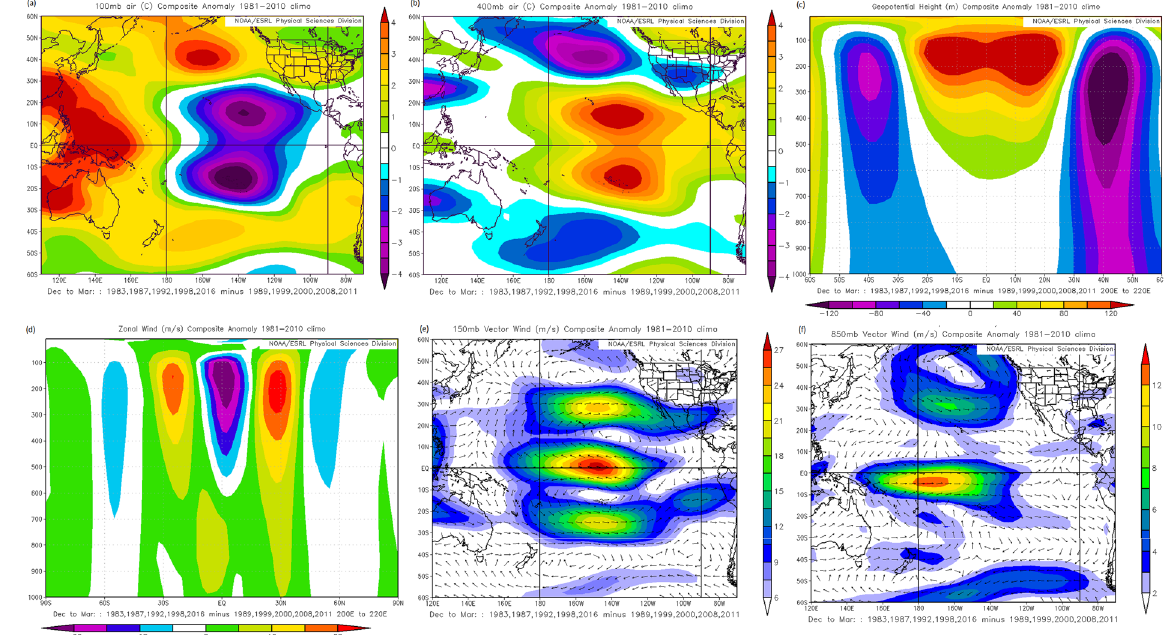
Figure 2. The El Nino minus La Nina mean difference composite spatial pattern for the; ( a ) 100 mb and ( b ) 400 mb level air temperature, 200°E–220°E averaged ( c ) vertical Z and ( d ) zonal wind slice, zonal wind at the ( e ) 150 mb and ( f ) 850 mb levels. The years comprising the composites are indicated in the inserts. The figure panels were generated using the online software from https://www.esrl.noaa.gov/psd/cgi-bin/data/composites/ printpage.pl and the corresponding NCEP/NCAR 32 datasets selected for construction of the composites are indicated in the